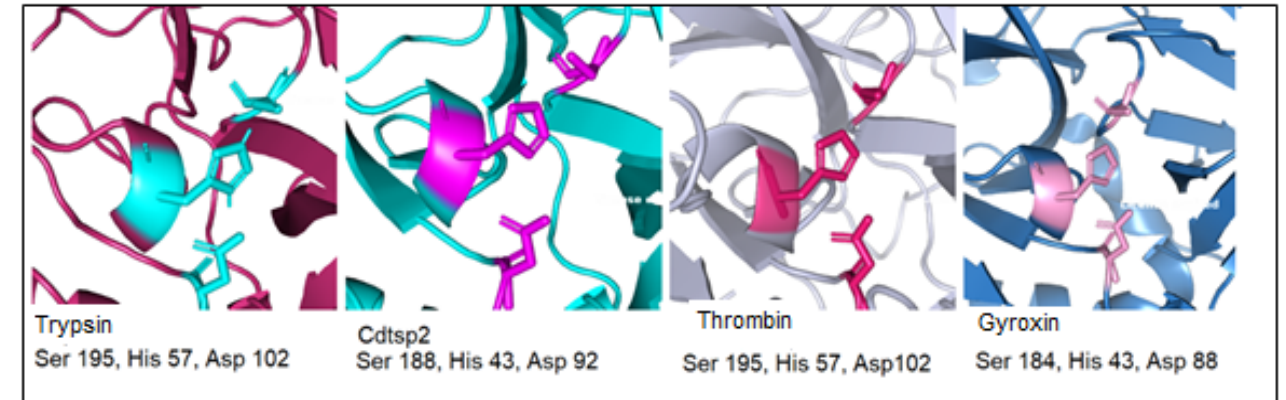
Figure 1. The active sites of the serine proteases are highly conserved regardless of their origin. Costa and collaborators isolated Cdtsp-2 ( Crotalus durissus terri fi cus serine protease